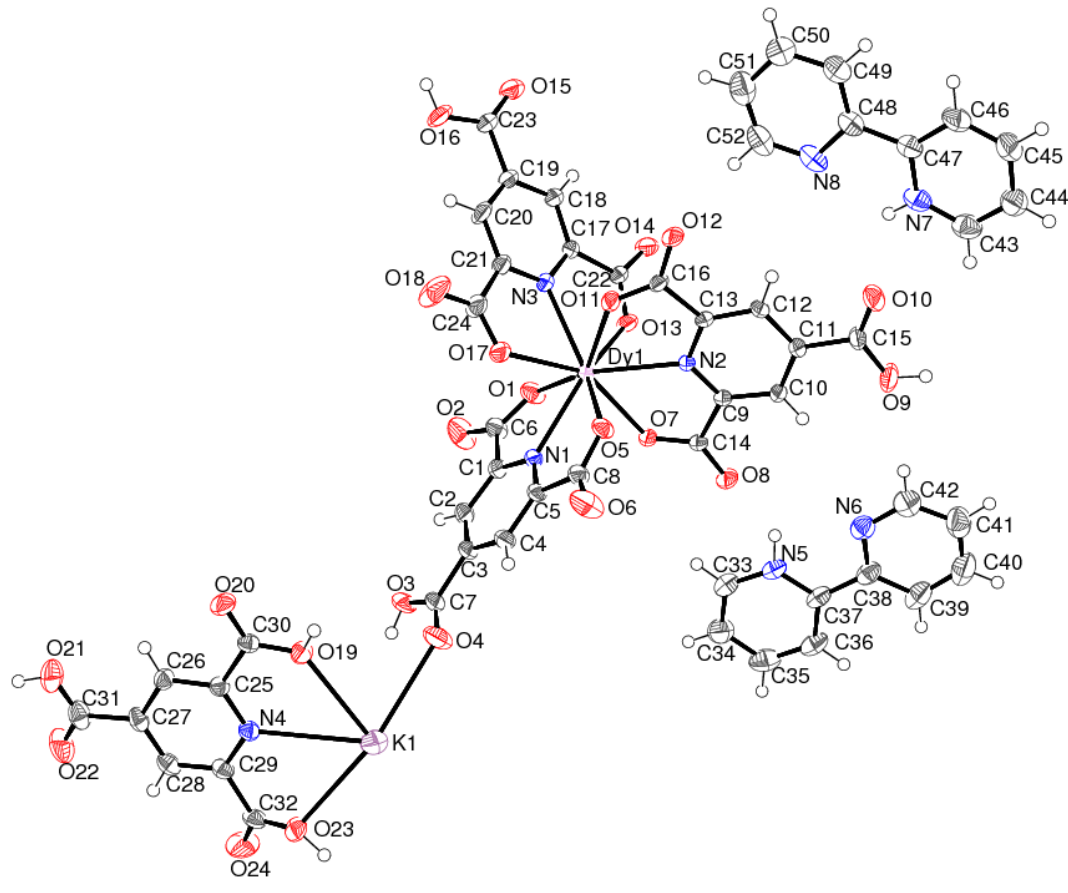
Figure 1. The asymmetric unit of 1 (50% displacement ellipsoids for the non-hydrogen atoms). The water molecules are omitted for clarity.